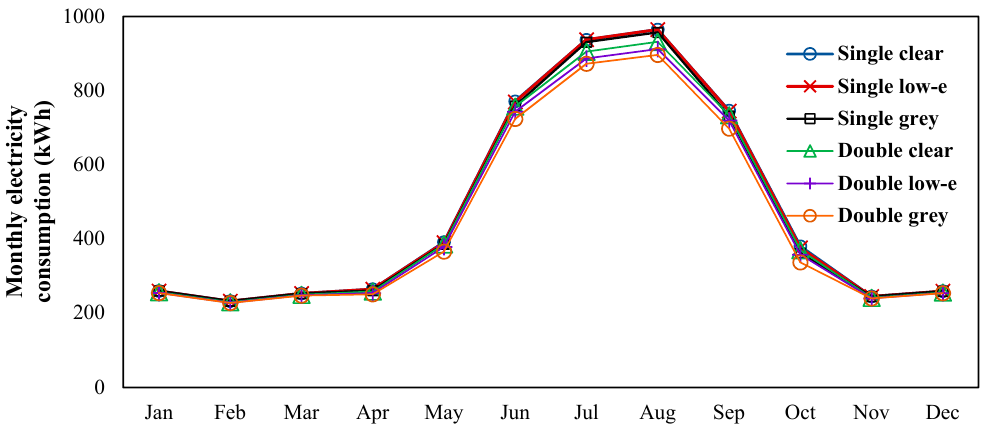
Figure 11. Monthly natural gas (NG) consumption for different glazing types.